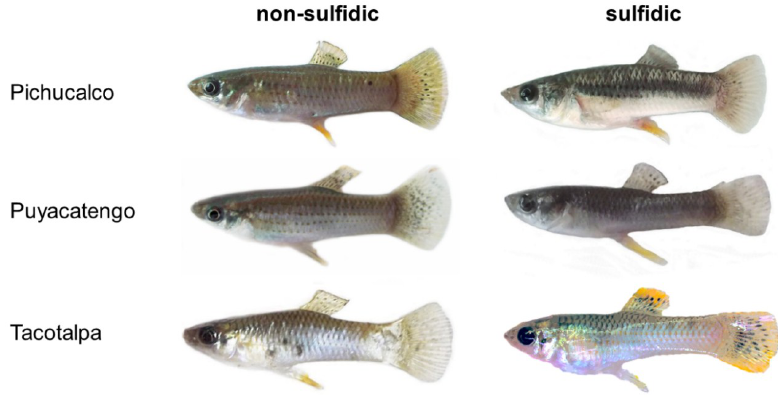
Figure 2. Examples of differences in body coloration of P. mexicana / P. sulphuraria males from non-sulfidic habitats (left) and the corresponding H 2 S-rich spring in the three focal river drainages in southern Mexico.